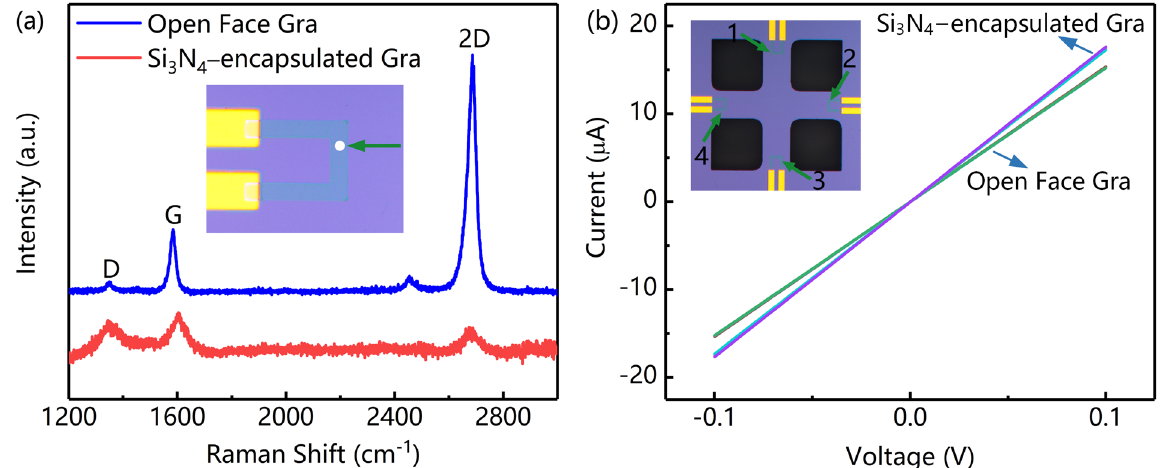
Figure 3. Physical and electrical characteristics of graphene sensing element. ( a ) Raman spectra of graphene sensing element before and after depositing Si 3 N 4 . ( b ) I − V curve of graphene sensing element with open face and Si 3 N 4 protective layer.